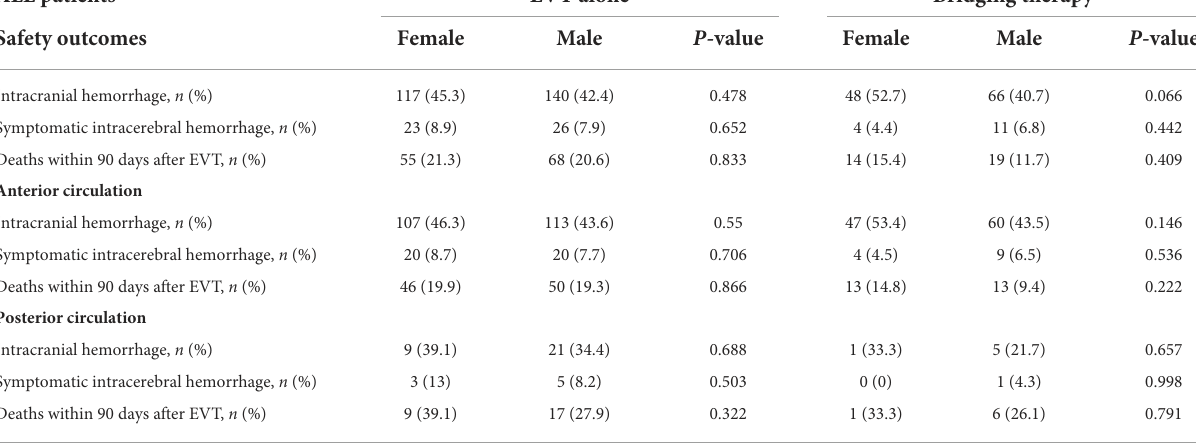
TABLE 3 Safety events in women and men. ALL